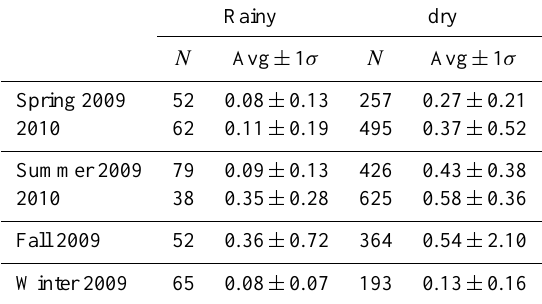
Table 4. Seasonal mean (denoted as avg) ± 1 σ values (ppqv) of Hg P at Appledore Island for rainy and dry conditions. N stands for the number of samples.